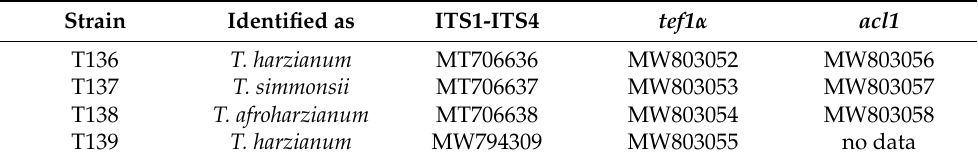
Table 1. Species assignment and accession numbers of Trichoderma strains isolated from the wheat endosphere in this